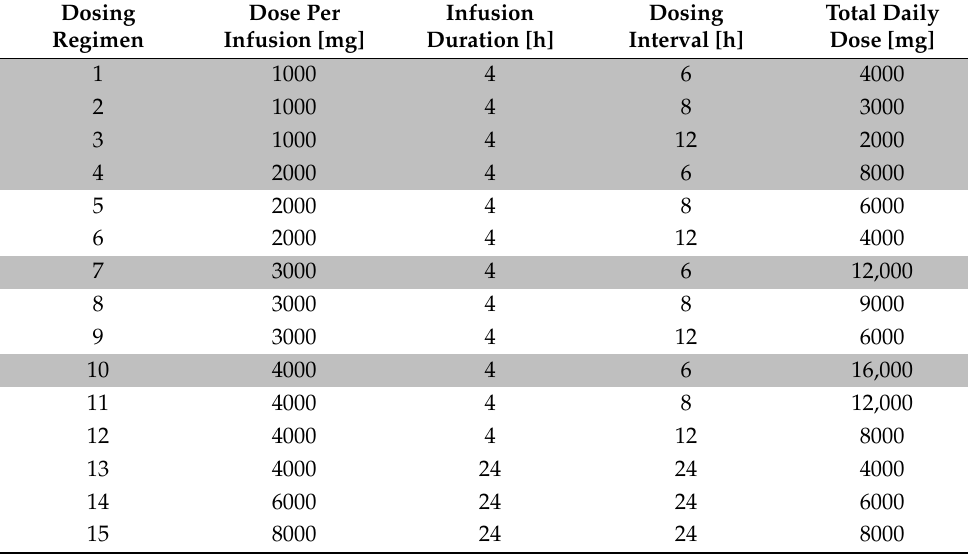
Table 1. Meropenem dosing regimens investigated in probability of target attainment analysis for potential inclusion in the dosing decision